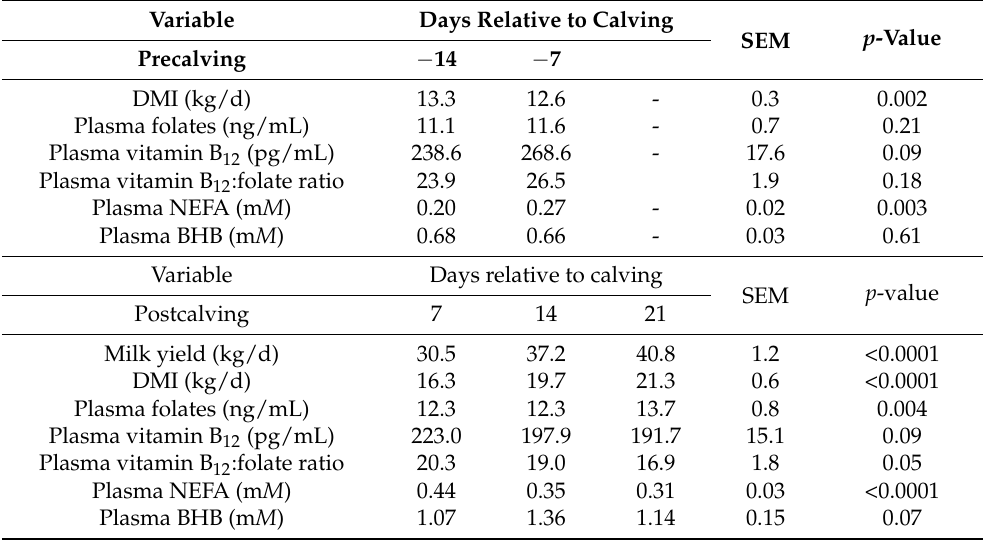
Table 1. Weekly averages of DMI, plasma metabolite concentrations, and milk yield from days − 14 to 21 relative to calving of 48 multiparous Holstein dairy cows.